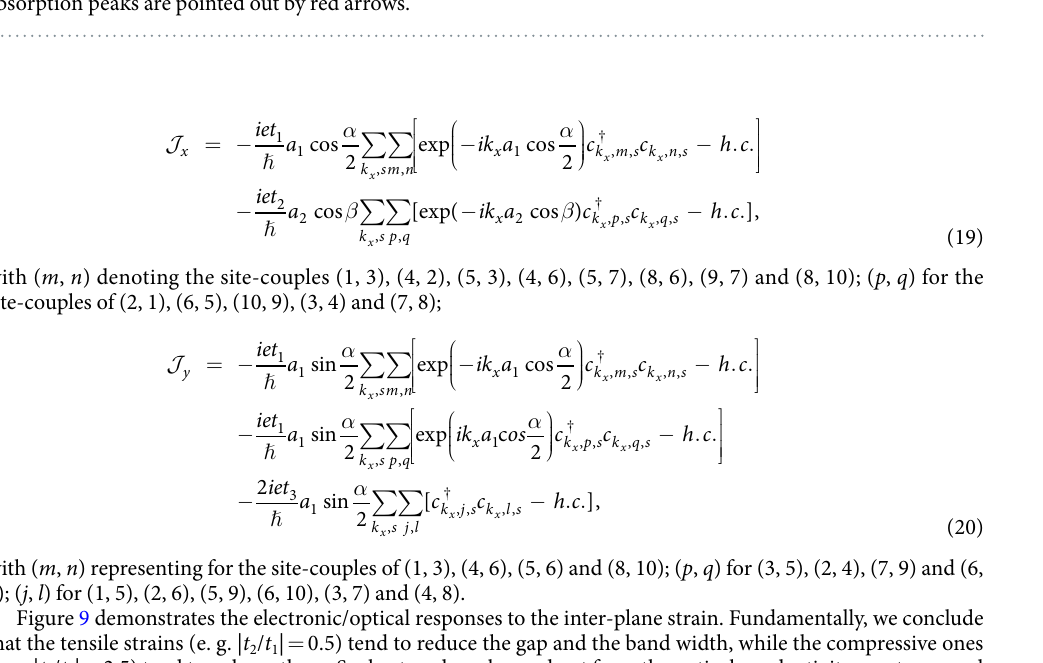
Figure 9. Same as Fig. 4, but for the case of 5a-Q1D-PNR. The interband transitions contributing to the main absorption peaks are pointed out by red